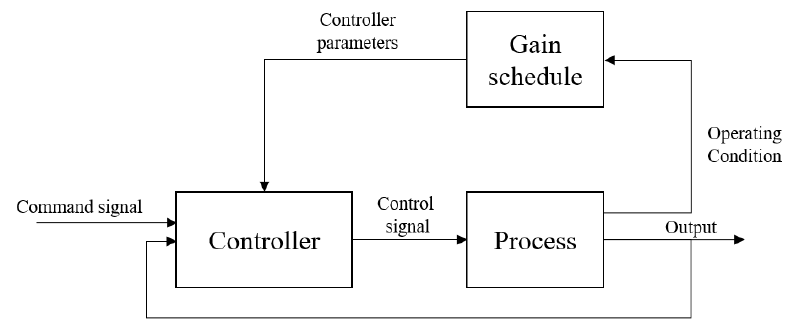
Figure 14. Gain scheduling controller design.